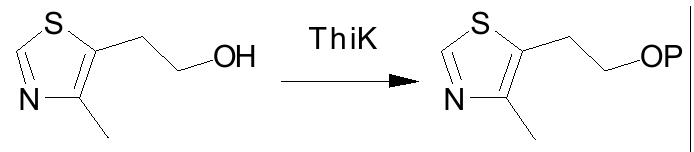
Figure 1. General scheme of thiazole kinase catalyzed